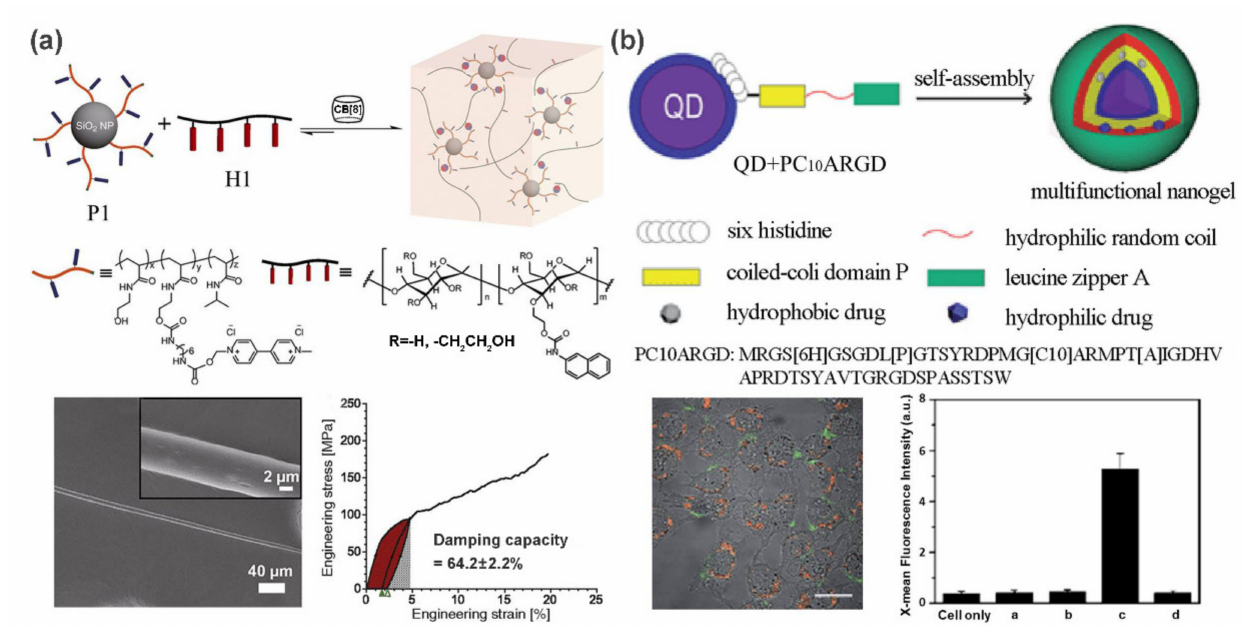
Figure 2. ( a ) CB [8]-mediated self-assembly of MV-functionalized silica nanoparticles and linear semicrystalline polymer into supramolecular nanocomposite hydrogel. Supramolecular fibers can be drawn from this hydrogel and exhibit a high damping capacity. ( b ) Schematic illustration of the formation process of QD/PC 10 ARGD nanogel. Confocal fluorescence image and flow cytometry analysis show its targeted imaging capable. Adapted with permission from Refs.